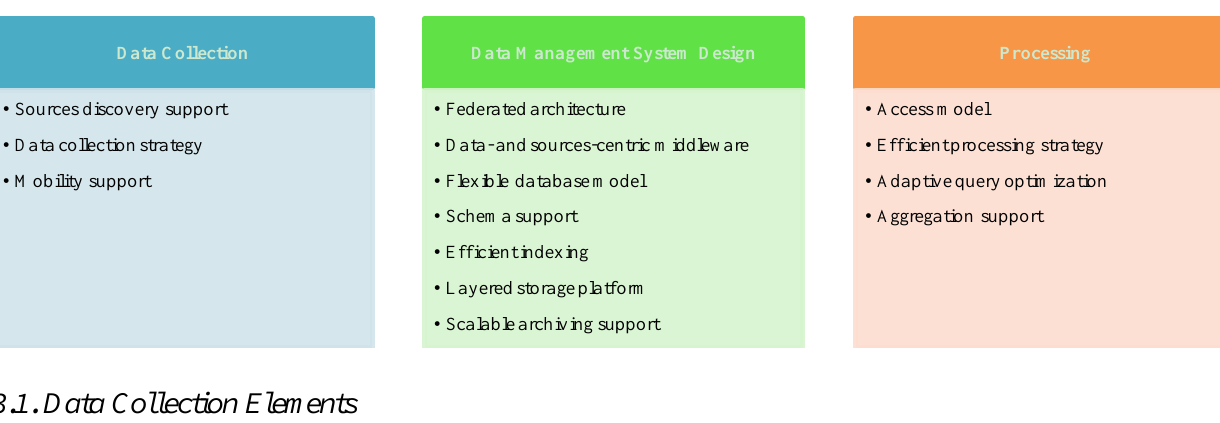
Figure 2. Design primitives for an IoT data management